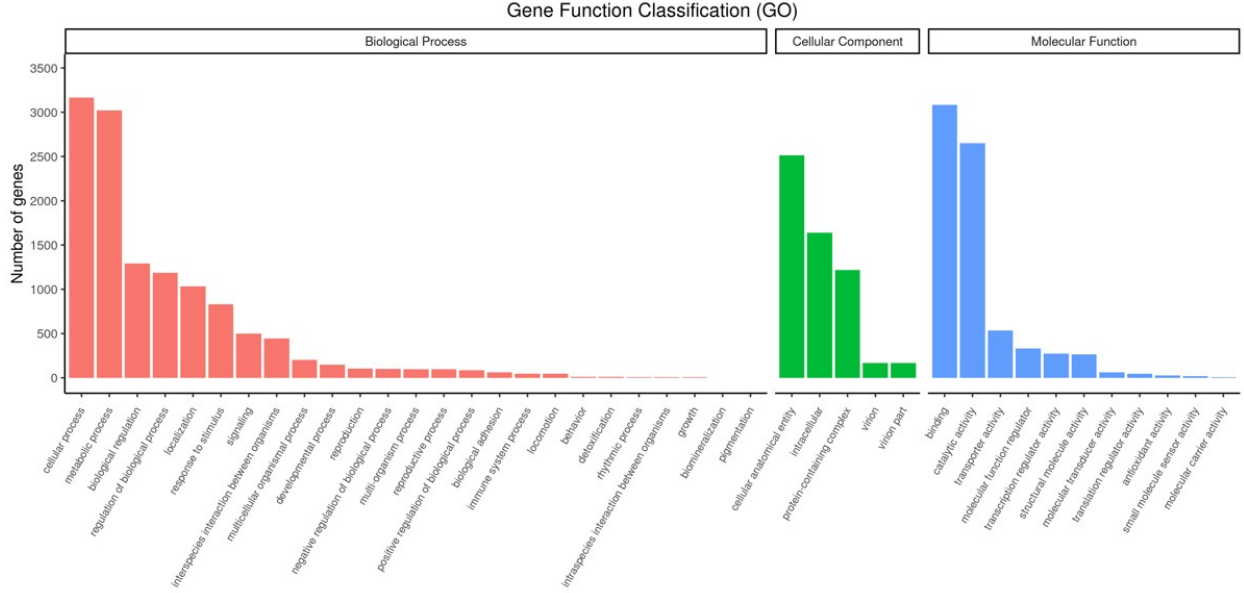
Figure 3. GO terms distribution of annotated unigenes in P . tuoliensis .